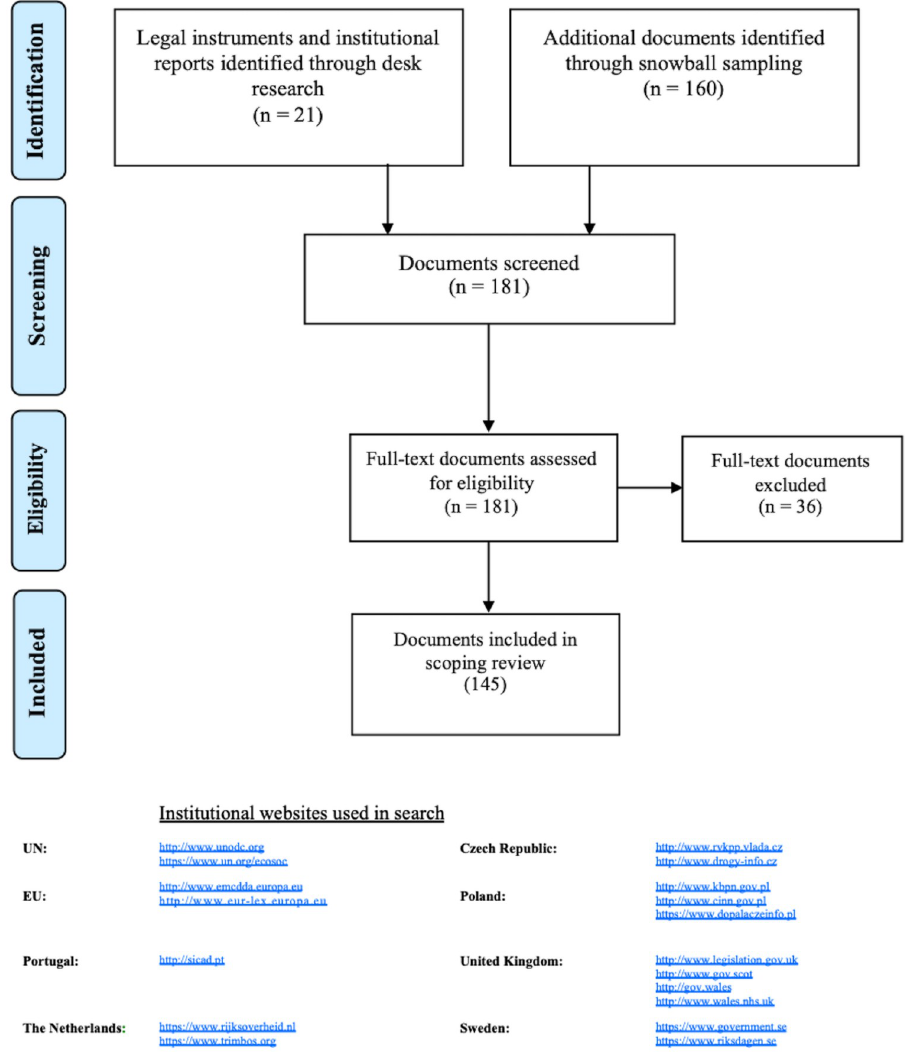
Fig 1. NPS Policy Mapping. Scoping Review Flow